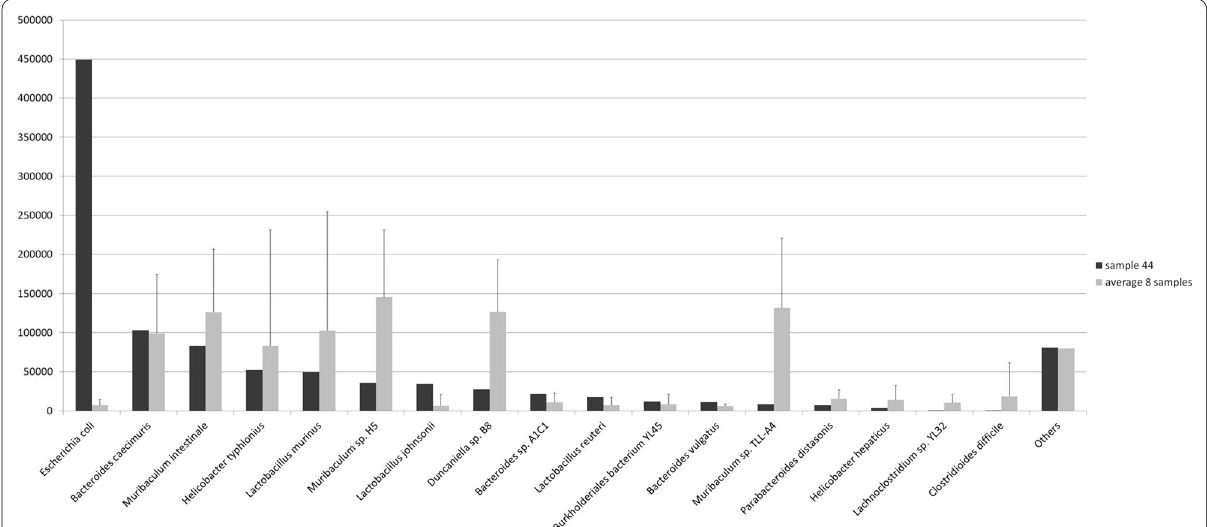
Fig. 7 Comparison between Escherichia coli ( E. coli ) positive samples. Graph shows species detected in sample 44 (normalized counts) and in the remaining 8 non-SPF samples positive for E. Coli (normalized average). Species with values greater than 100 ppm in at least one of the two groups of samples are represented. E. Coli represents 45% of the total reads in sample 44, while the average in the other samples is 0.7%. Among the most abundant species belonging to Muribaculum genus, all are reduced in sample 44, as a whole, from 40 to